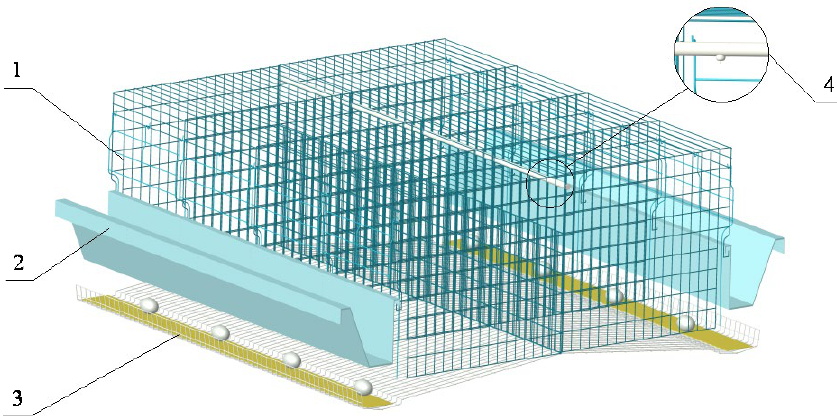
Figure 3. Appearance diagram of duck cage: (1) push-in cage door, (2) food trough, (3) conveyor belt, (4) nipple-shaped drinker.